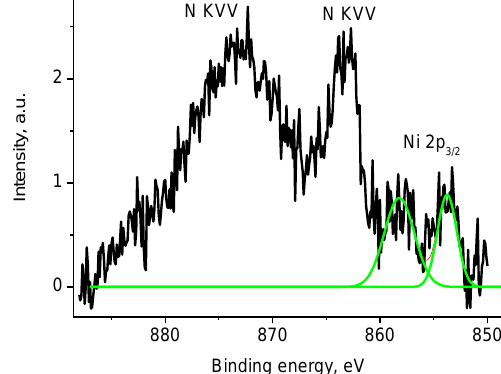
Figure 23. The S 2p, Gd 4d, and P 2p photoelectron spectra of sample Pt/1′ recorded using Al Kα (1) and Mg Kα (2) radiations.